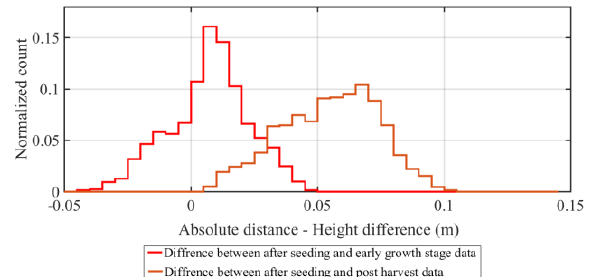
Figure 9. Height differences between after seeding reference and two alternatives